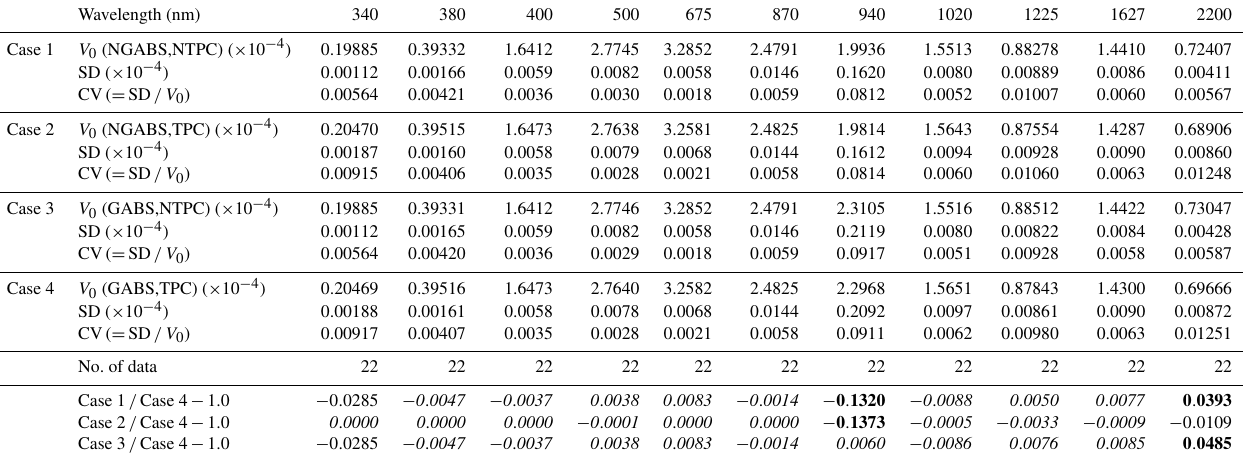
Table 2. Example of calibration constants ( V 0 ) determined by using the data taken at MLO. Wavelength (nm)